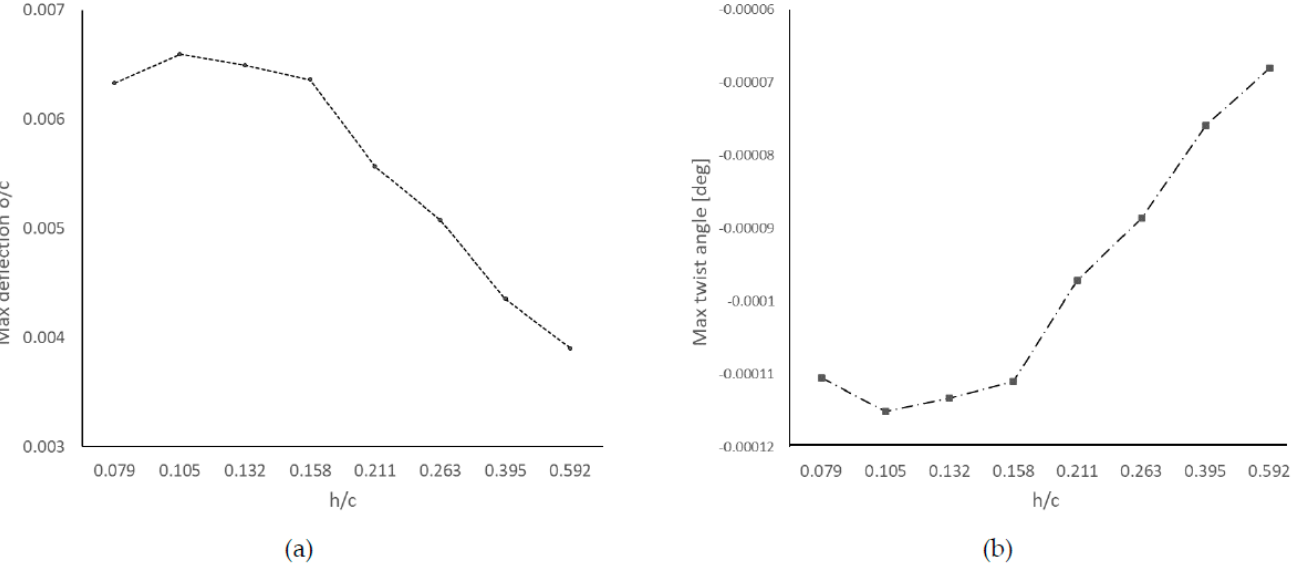
Figure 12. Deflection of double-element wing at various ride heights: ( a ) non-dimensional maximum deflection, ( b ) maximum twist angle.